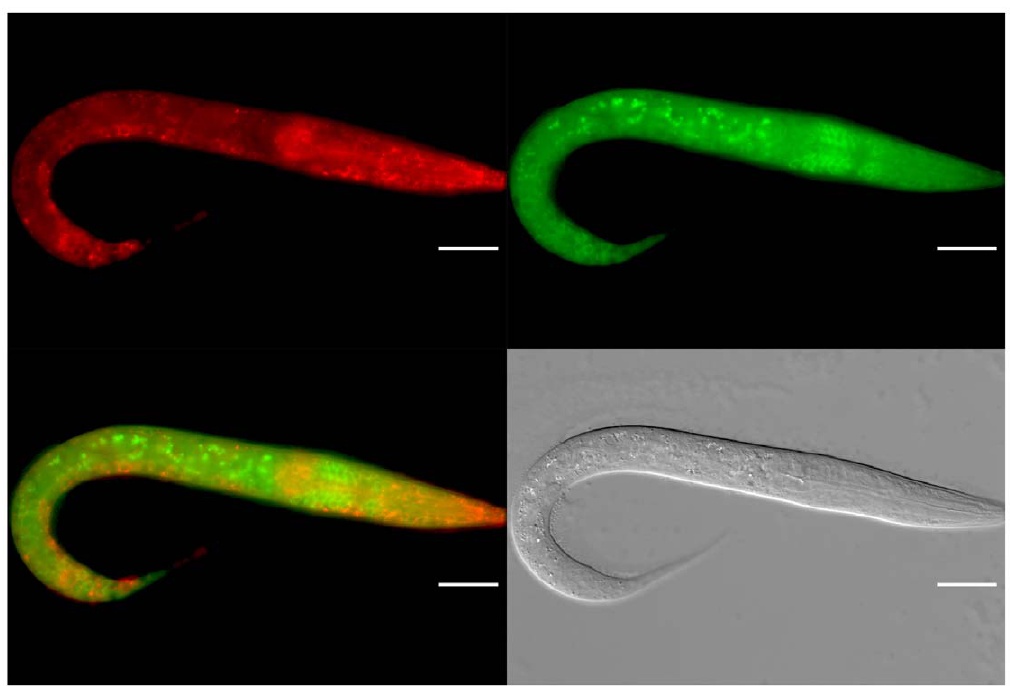
Figure 4. Embryonic ALG-1 and ALG-2 expression. The expression onset of GFP::ALG-2 and RFP::ALG-1 differs. RFP::ALG-1 fluorescence is first detected at the beginning of the morphogenetic phase (B). Scale bar 20 m m.